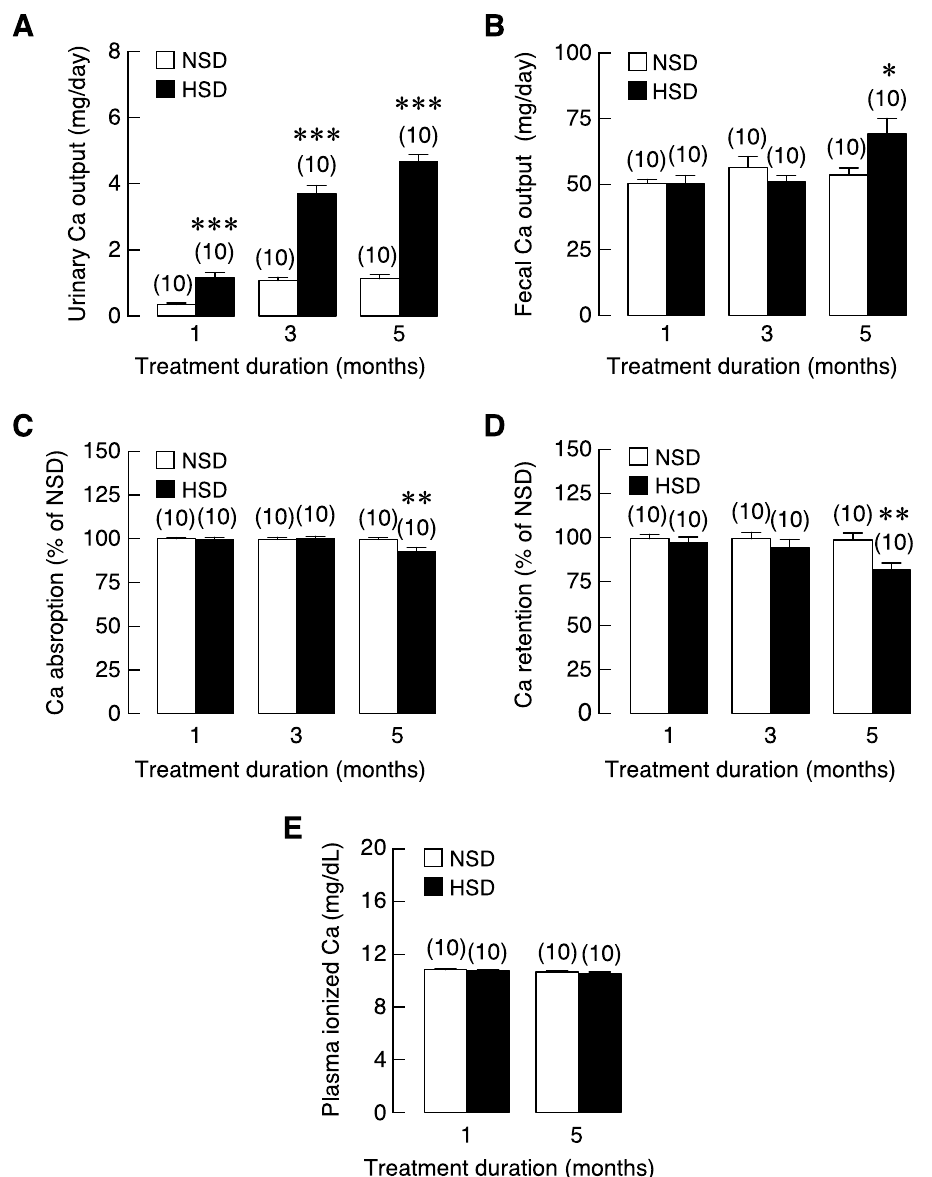
Figure 3. Longitudinal study of calcium balance in NSD and HSD. ( A ) Calcium output from urine, ( B ) calcium output from feces, ( C ) percentages of calcium absorption, ( D ) percentages of calcium retention, and ( E ) plasma ionized calcium. Numbers of animals in each group are shown in parentheses. * P < 0.05, ** P < 0.01 and *** P < 0.001 compared to